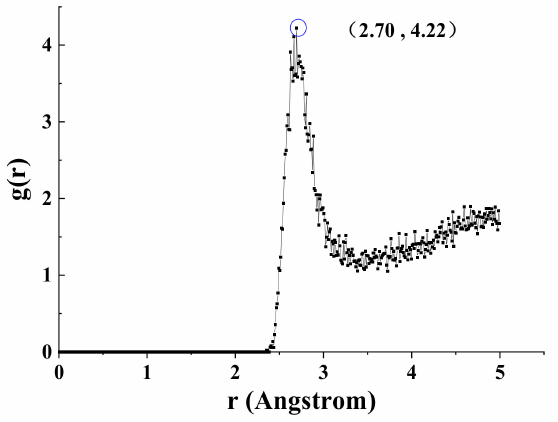
Figure 10. RDF of APG head groups and water molecules.